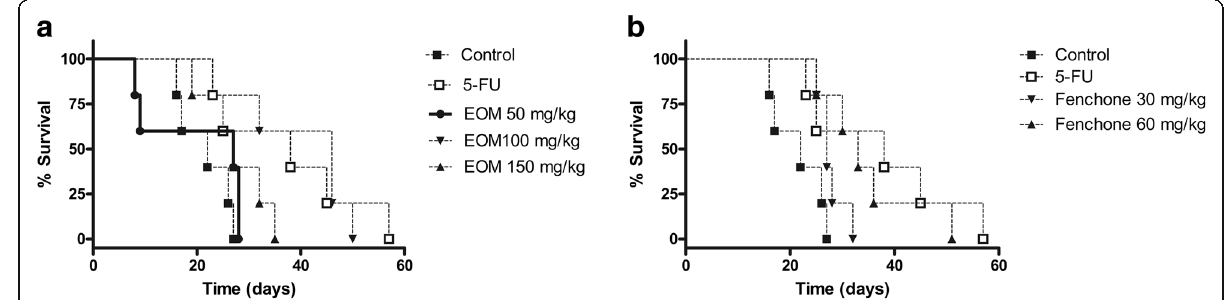
Fig. 2 Survival times of female mice inoculated with Ehrlich carcinoma cells and treated with EOM ( a ) and Fenchone ( b ). Data presented as mean ± SEM of six animals analyzed by Kaplan-Meier